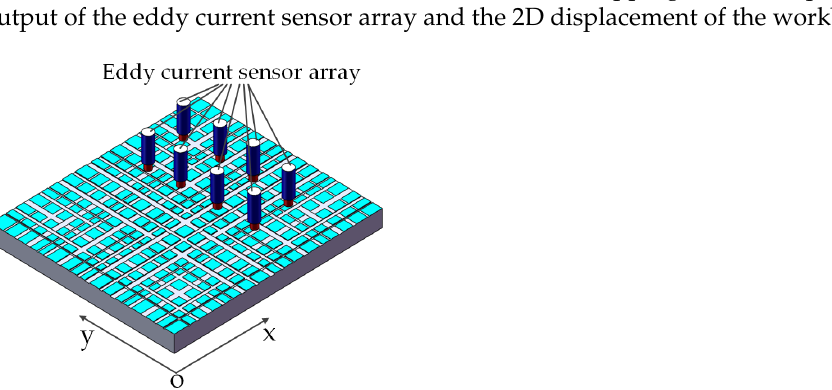
Figure 1. Principle diagram of the 2D displacement measurement method.